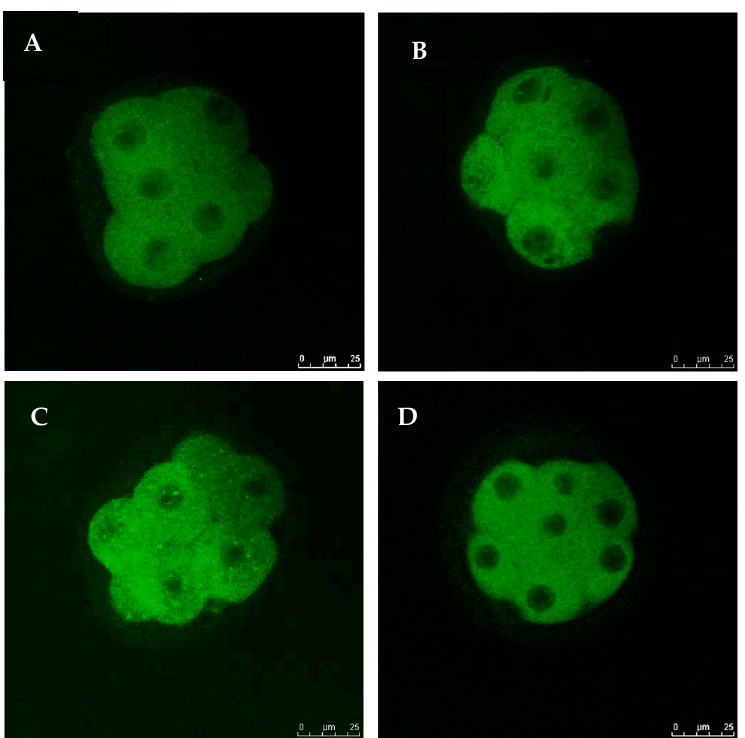
Figure 7. Fluorescent photomicrograph of embryos showing cytochrome c expression. Images are viewed under 40X magnification. ( A ): Embryo from Group 1 (GSH-free medium); ( B ): embryo from Group 2 (GSH-supplemented medium); ( C ): embryo from Group 3 (GSH-free medium with vitrification); ( D ): embryo from Group 4 (GSH-supplemented medium with vitrification).